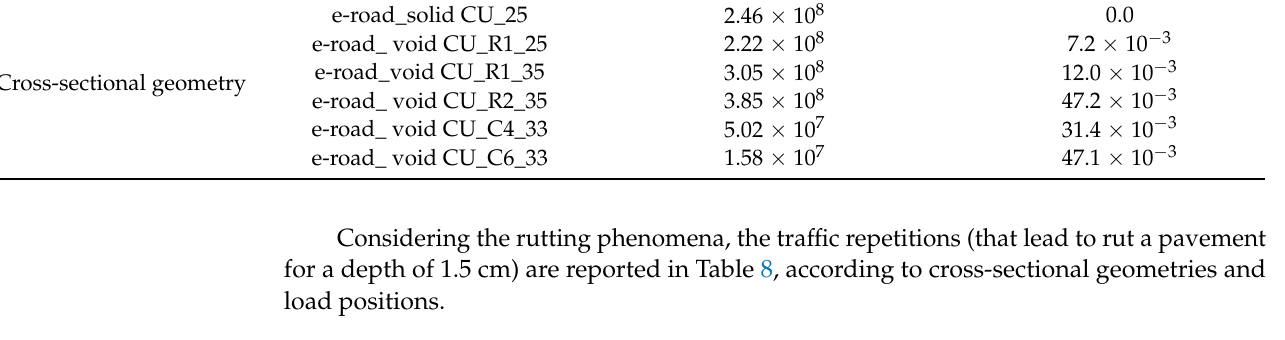
Table 8. Number of traffic repetitions n [ESAL] leading to a critical rut